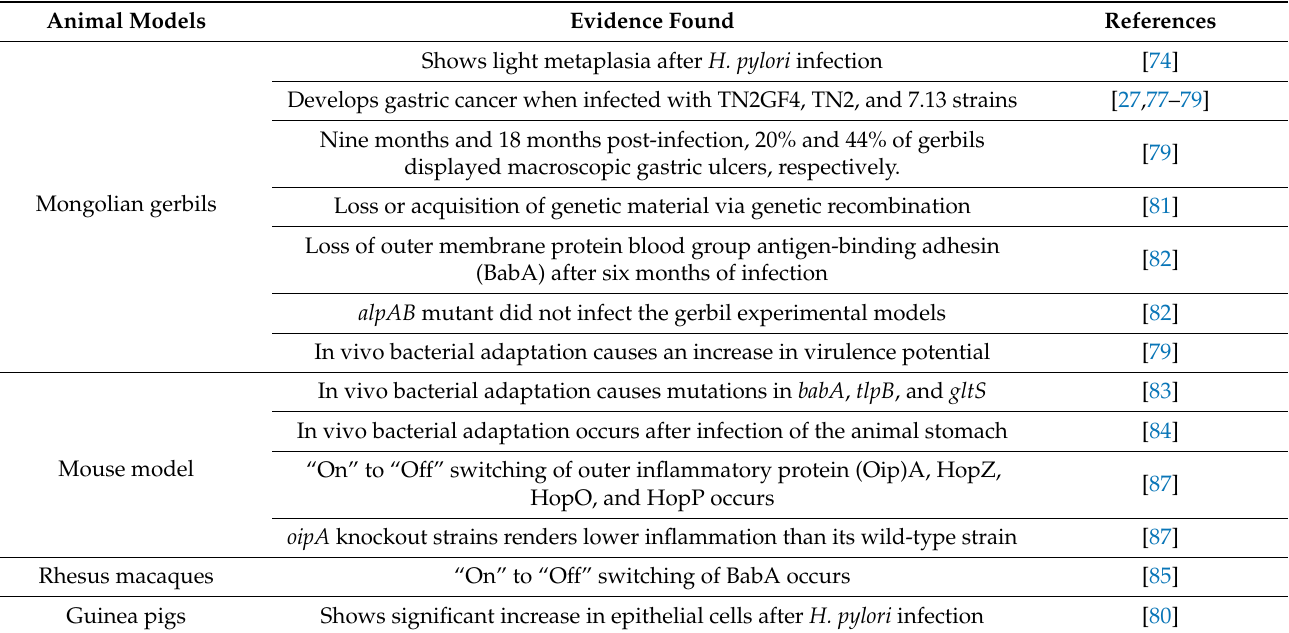
Table 1. Role of H. pylori and outer-membrane proteins in gastric pathogenicity in animal models. Animal